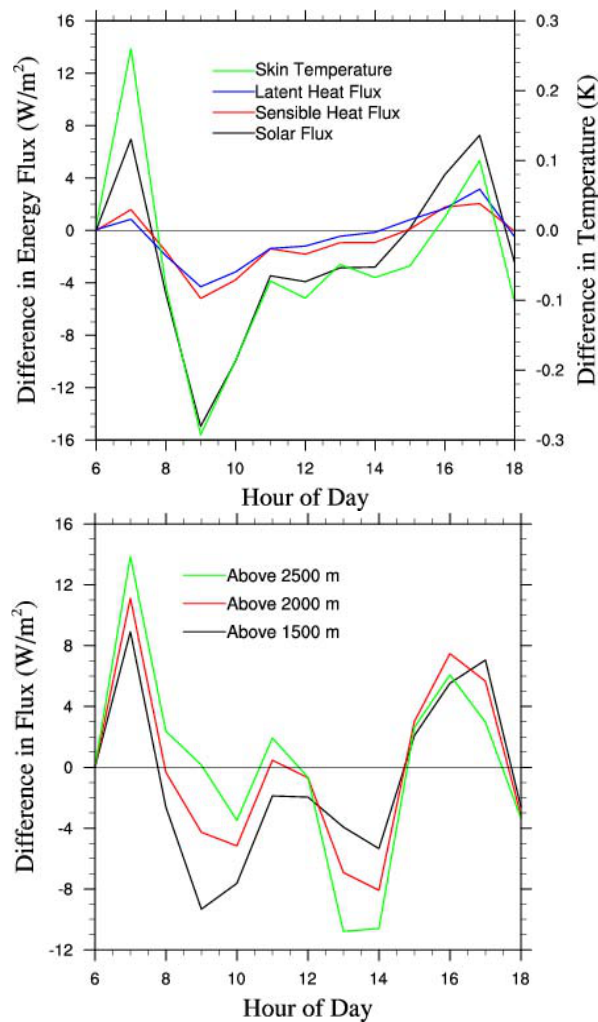
Fig. 7. Differences in the (a) domain-averaged diurnal variation of surface solar flux (black, Wm − 2 ), sensible heat flux (red, Wm − 2 ), latent heat flux (blue, W m − 2 ), and surface skin temperature (green, K) and (b) domain-averaged diurnal variation of surface solar flux (Wm − 2 ) for mountain regions above 1500m (black), 2000m (red), and 2500m (green) over the Sierra-Nevada area on 29 March